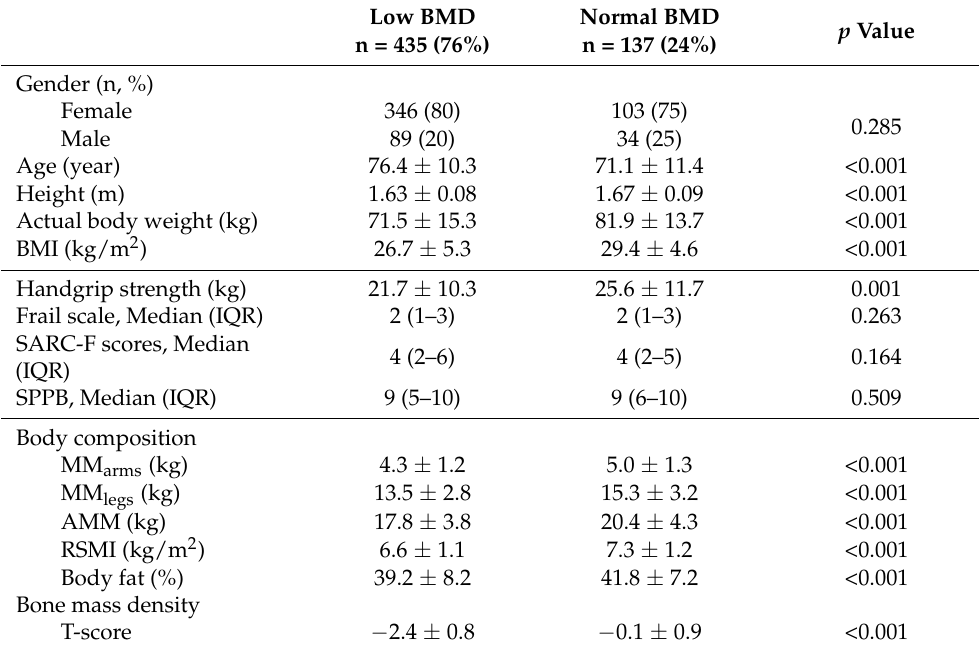
Table 3. Comparison of patients with low and normal